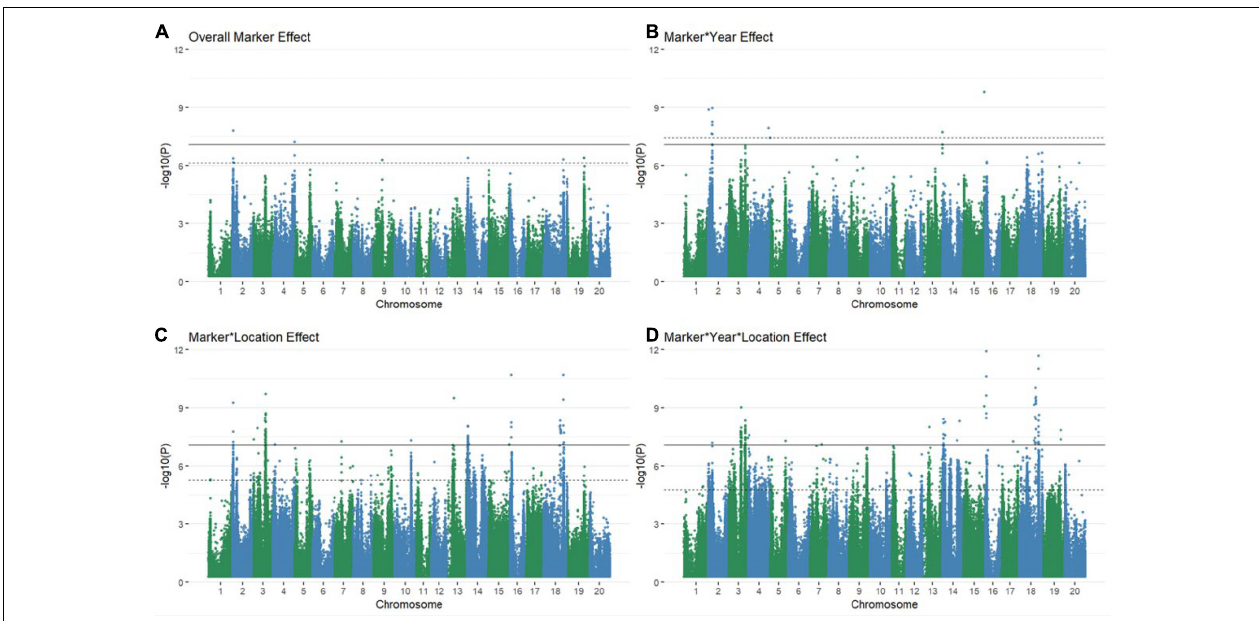
FIGURE 1 | Manhattan plots of marker (A) and marker by environment (B–D) levels modeled explicitly as random explanatory variables of raw grain yield. Several associations are significant at every level via both the Bonferroni correction (solid black line) and a 5% FDR (dashed line) with some overlap between QTL discovered for varying levels of GxE interactions (B–D)